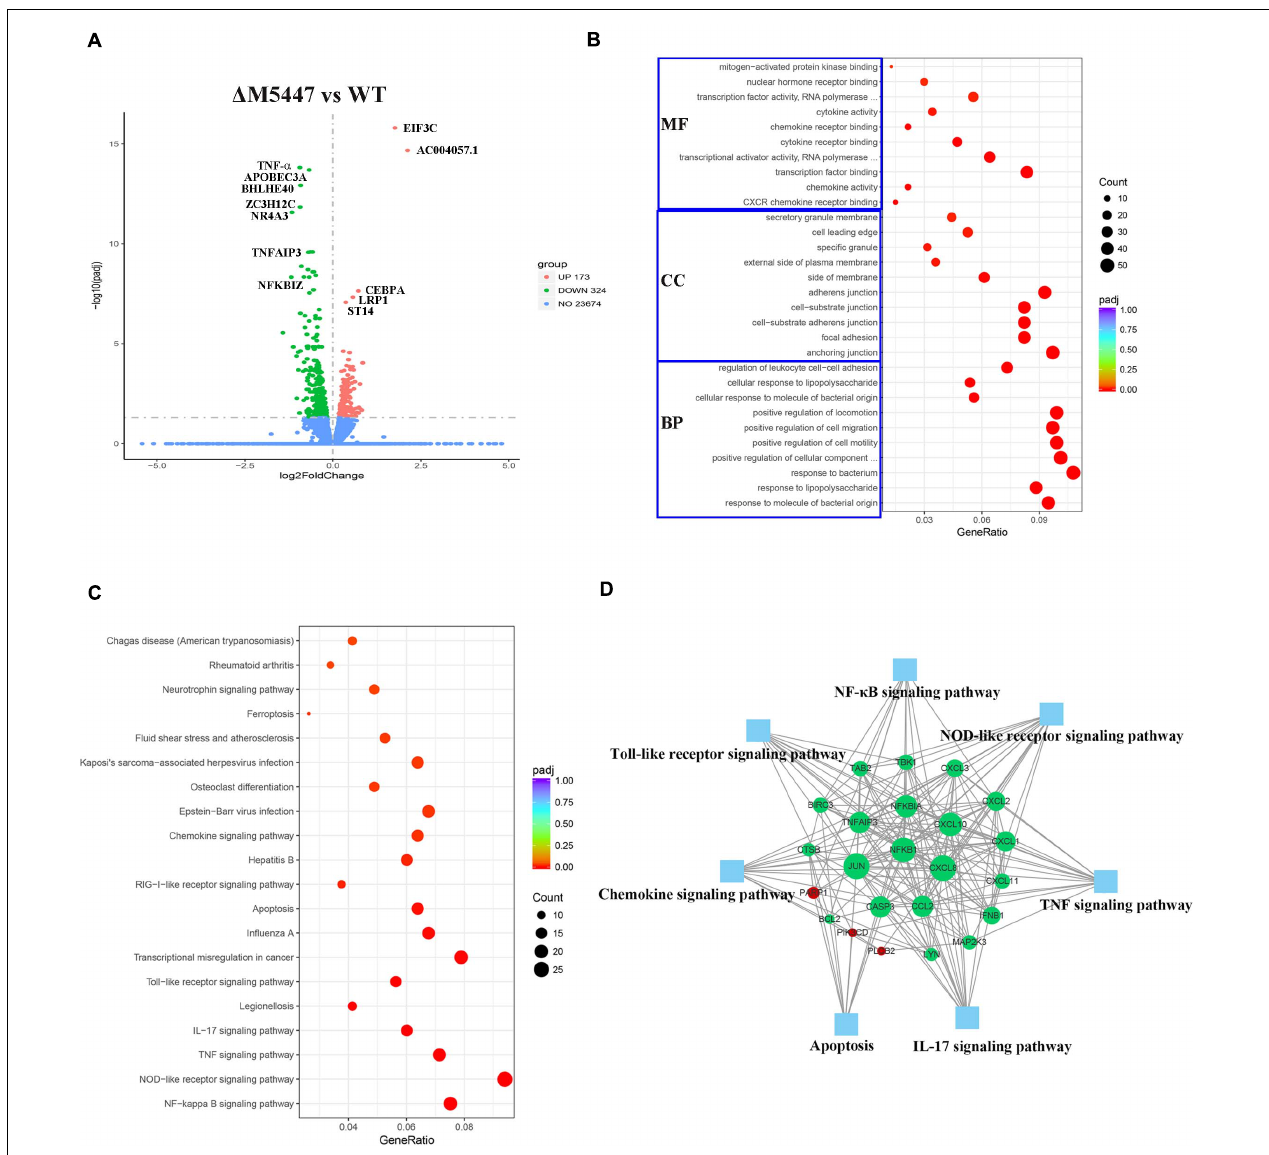
FIGURE 8 | Transcriptional profiles of macrophages during mycobacterial infection. THP-1 macrophage cells were infected with Wt and (cid:49) M5447 strains for 3 h, and the total RNA of THP-1 cells was extracted at 24 h post-infection. (A) Volcano plots of differentially expressed genes (DEGs) in (cid:49) M5447-infected THP-1 cells as compared to the Wt-infected THP-1 cells. The name of DEGs was annotated next to the dots. Blue, green, and red splashes represent genes without significant change, significant down-regulation, and significant up-regulation, respectively. (B) Scatter plot of GO functional classification of the DEGS. The distributions are summarized in three main categories: biological process (BP), molecular function (MF), and cellular component (CC). GeneRatio is the ratio of the DEG number to the total gene number in each category. The color and size of the dot represent the range of the adjusted p -value and the number of DEGs mapped to the categories. The top 10 functions in each category are shown in the figure. (C) Scatter plot of enriched KEGG pathways. GeneRatio is the ratio of the DEG number to the total gene number in a certain pathway. The color and size of the dot represent the range of the adjusted p -value and the number of DEGs mapped to the indicated pathways, respectively. The top 20 enriched pathways are shown in the data. (D) Interaction of key genes that presented in two pathways at least were analyzed by STRING and shown by Cytoscape software. Green and red nodes represent the down- and up-regulated genes, respectively. The size of the node indicated the core role of the gene. Blue squares represent the KEGG